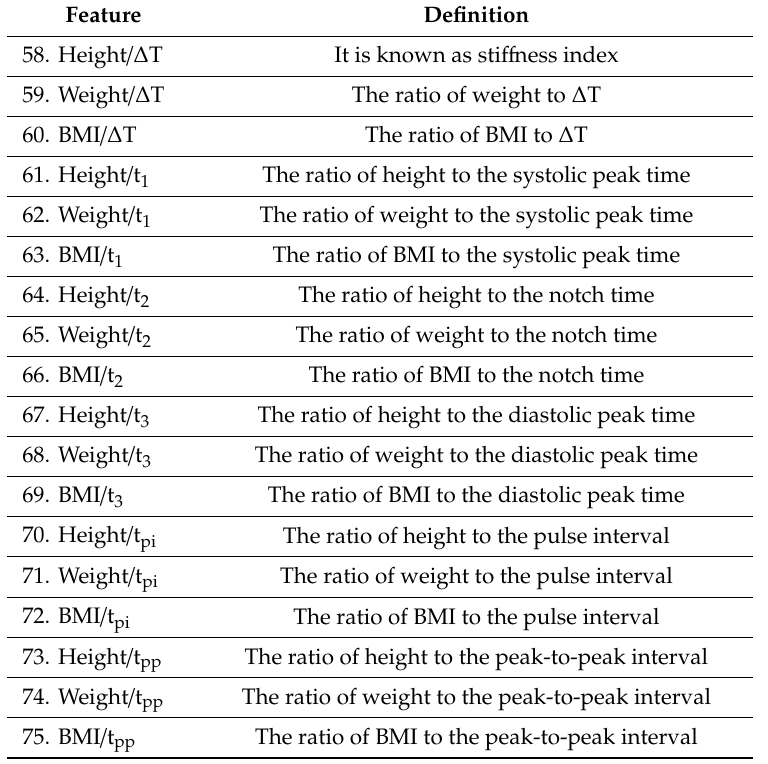
Table 5. Eighteen demographic time-domain